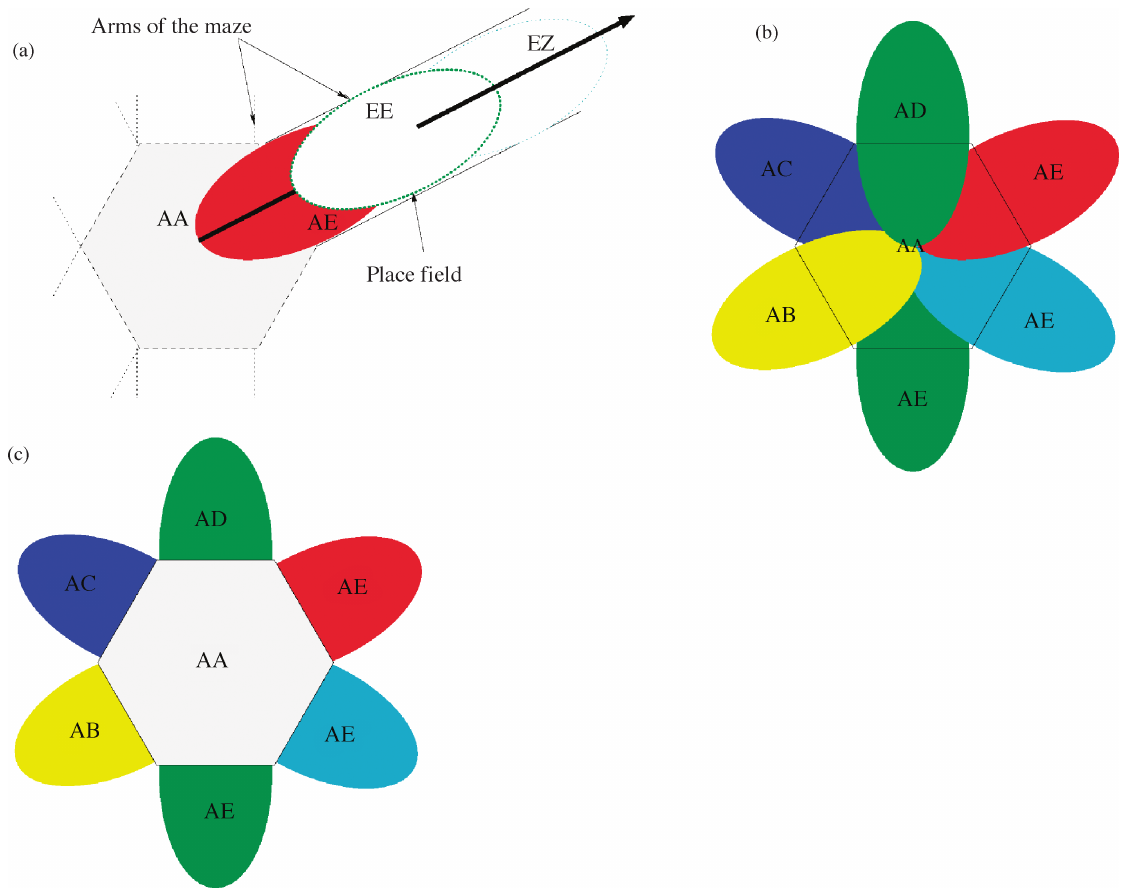
Figure 14. Sketch of place field response in a star maze. ( a ) In a constraint environment like the arm of a maze, only a small number of transitions is possible starting from a given place EE. ( b ) At the opposite, at the center of the maze (AA), several transitions are possible, each leading to a given arm of the maze. ( c ) The overlap of the transition field starting from the center can lead to a non-directional place field for